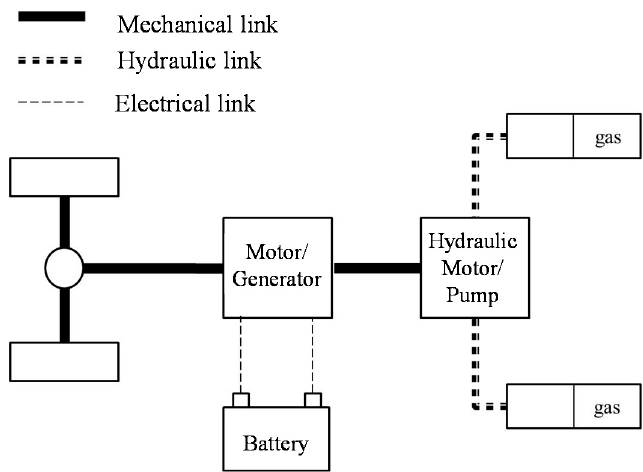
Figure 5. Hydraulic electric hybrid vehicle (HEHV) configuration.